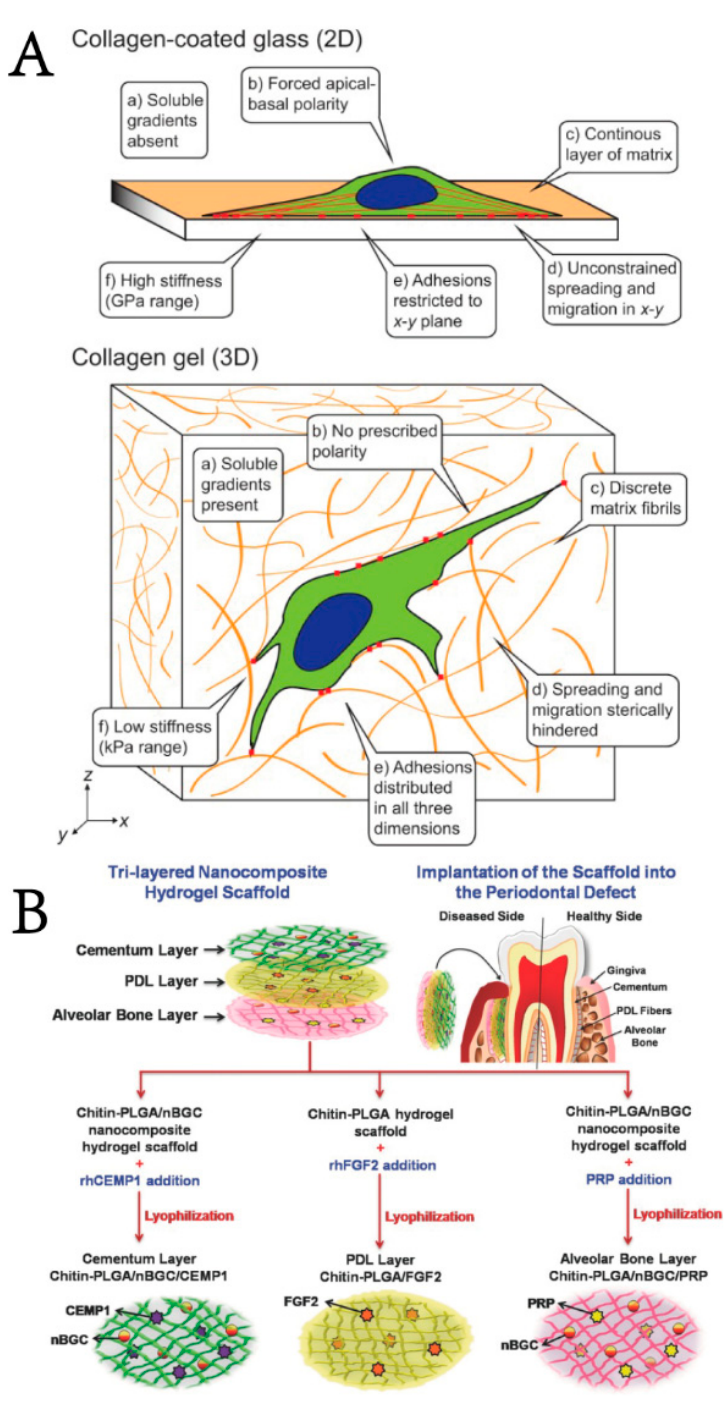
Figure 2. Schematic representation of ( A ) the different bioactive cues encountered by a cell between 2D substrates or in 3D microenvironments (Used with permission of Ref. [102], permission con-veyed through Copyright Clearance Center, Inc, Danvers, MA, USA) and ( B ) a trilayered nanocomposite hydrogel scaffold with a similar structure of cementum-periodontium-alveolar bone for simultaneous and complete periodontal regeneration (ab: alveolar bones; pl: periodontal ligaments; d:dentin; CEMP1: cementum protein-1; FGF-2: fibroblast growth factor-2; PRP: platelet-rich plasma; nBGC: nanobioactive glass ceramic; rhCEMP1: recombinant human cementum protein-1; rhFGF: re-combinant human fibroblast growth factor) (Adapted with permission from [108], Copyright 2017 WILEY-VCH Verlag GmbH & Co. KGaA, Weinheim,